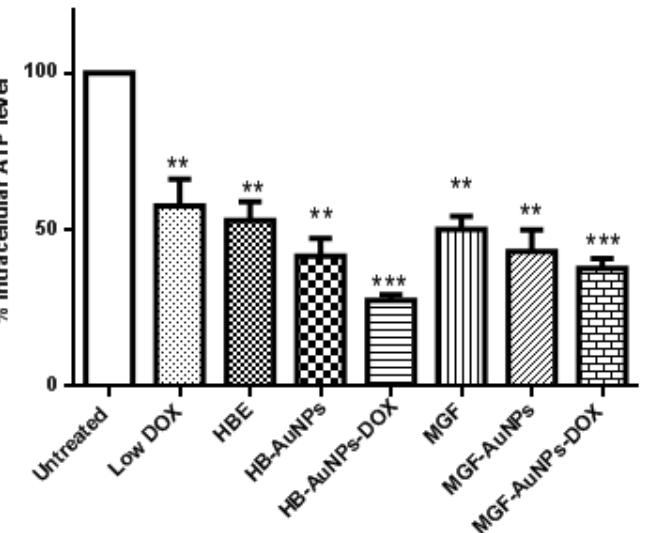
Figure 3. Effect of treatments on intracellular ATP levels in Caco-2 cells. Cells were treated with Low DOX (1.56 µg/mL), MGF (1000 µg/mL), HBE (1000 µg/mL), MGF-AuNPs (1000 µg/mL), HB-AuNPs (1000 µg/mL), MGF-AuNPs-DOX (1000 µg/mL MGF-AuNPs and 1.56 µg/mL DOX) and HB-AuNPs-DOX (1000 µg/mL HB-AuNPs and 1.56 µg/mL DOX). ATP levels were assessed using the Mitochondrial ToxGlo assay. Notes: Results are expressed as mean ± standard error of the mean (SEM). n = 3. Data were considered statistically significant if p < 0.05, *** p < 0.001, ** p < 0.01.